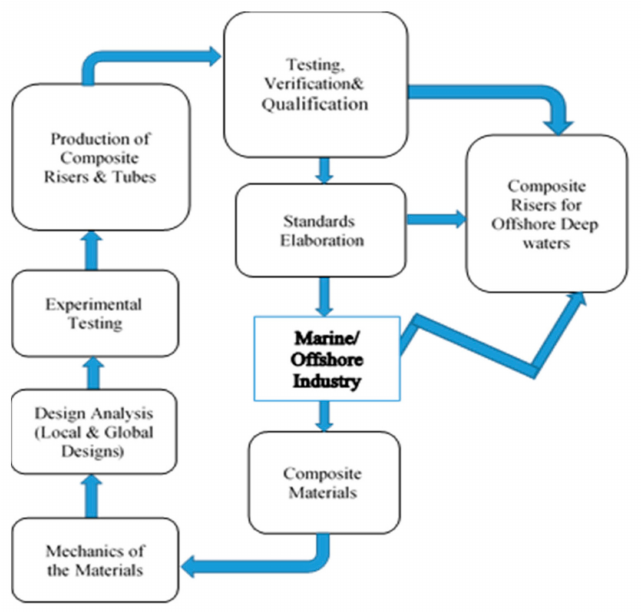
Figure 4. Reflection on sections and aspects covered in this composite riser